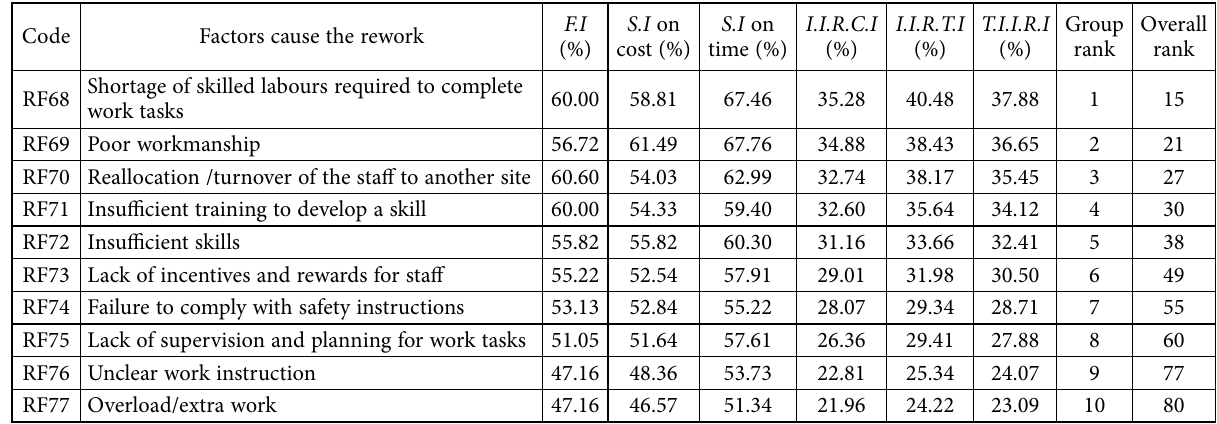
Table 11. Ranking the causes and impact of rework factors related to the